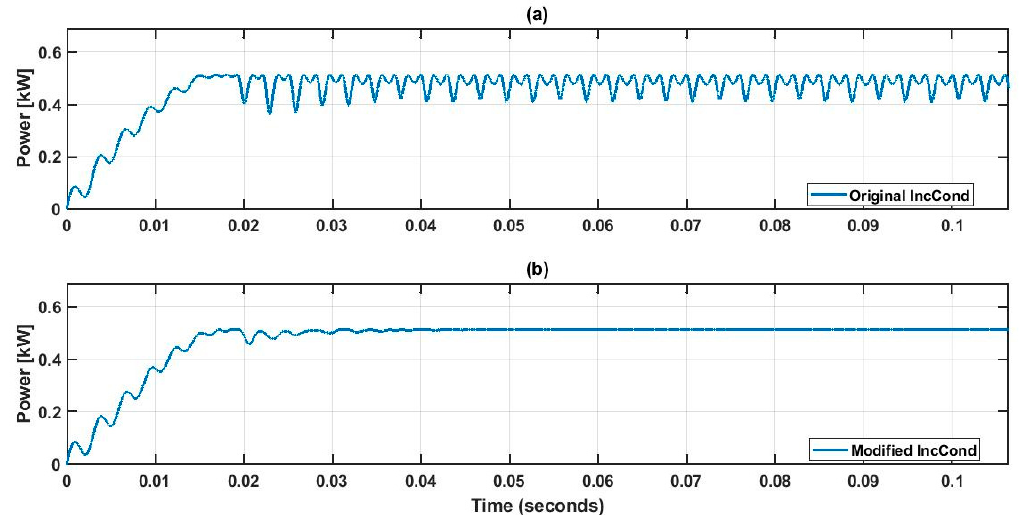
Figure 15. High-power PV system response time and perturbations: ( a ) original IncCond algorithm and ( b ) modified IncCond algorithm.